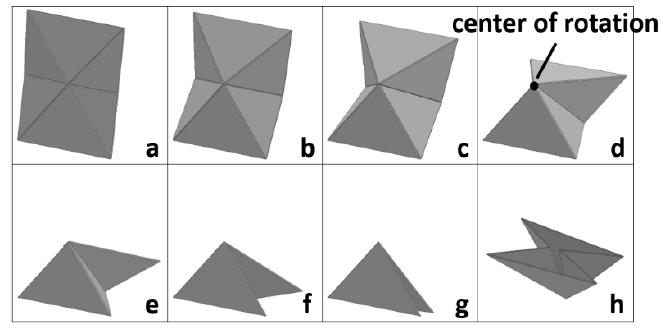
Figure 3. Snapshots of the origami ‐ based spherical six ‐ bar linkage. All axes of the flexure joints (folding line) pass through the rotation center indicated in ( d ). The pattern is folded from ( a – g ). The backside of the pattern is shown in ( h ).